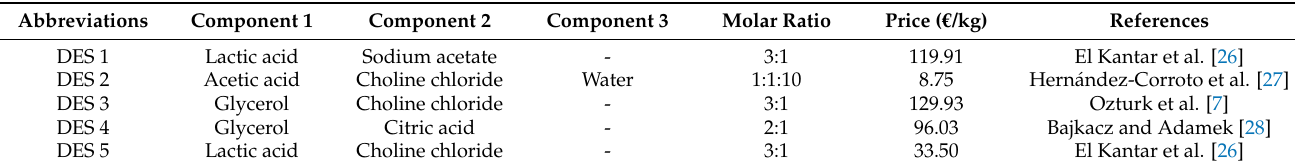
Table 1. Components, molar ratio, price and abbreviations of deep eutectic solvents (DES) employed in this work.